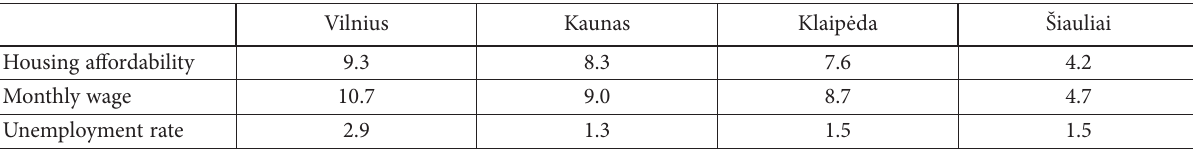
Table 9. VIF (variance inflation factors) of independent variables in different cities of Lithuania